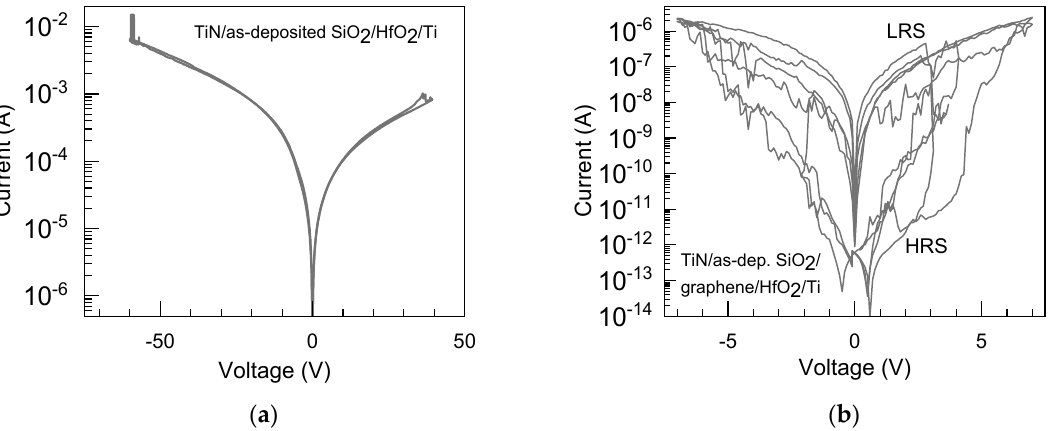
Figure 6. Current–voltage characteristics measured in resistive switching regime on TiN/SiO 2 /HfO 2 /Ti (Sample 2) ( a ) and TiN/SiO 2 /graphene/HfO 2 /Ti (Sample 1) ( b ) cell structures (Table 1) containing as-deposited SiO 2 and HfO 2 dielectric films. The diameter of the top titanium electrode was 250 µm. LRS and HRS denote the low- and high-resistance states, respectively. Further measurements were performed on the TiN/SiO 2 /HfO 2 /Ti (Sample 4) cell